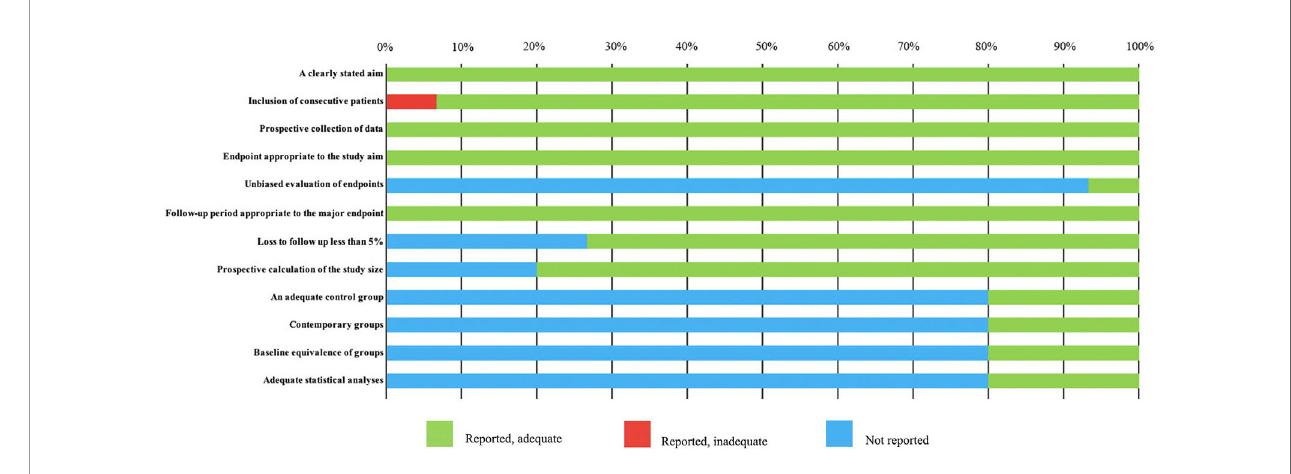
FIGURE 3 | MINORS quality assessment.